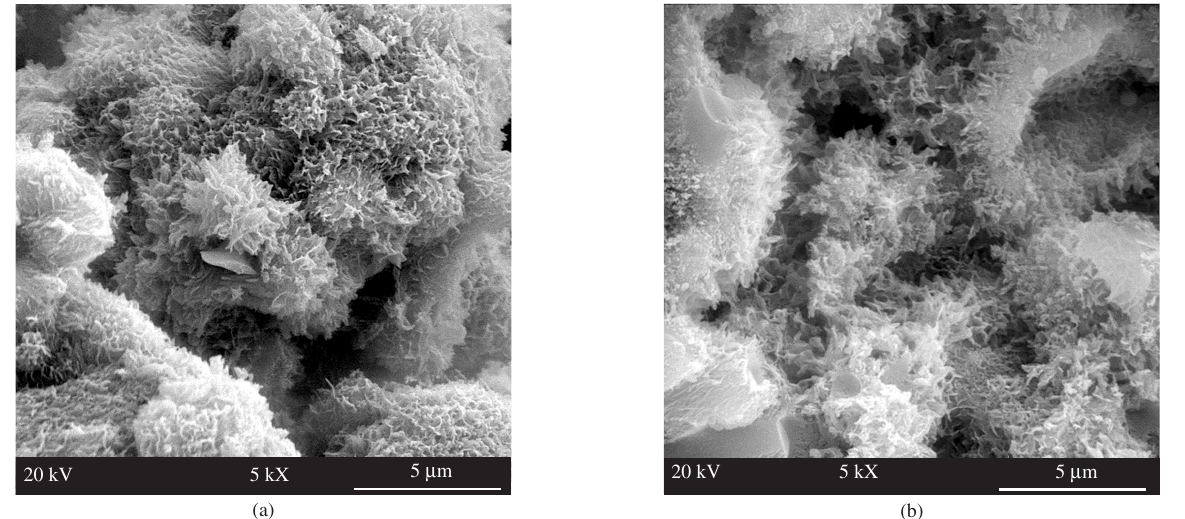
Figure 8. a) Microporosity and crystalline fiber when the molar ratio of Ca/P = 1.4 for 7 days of hydration; and b) shows microporosity and nanometric crystal- line fiber when the molar ratio of Ca/P = 1.5 for 7 days of hydration.